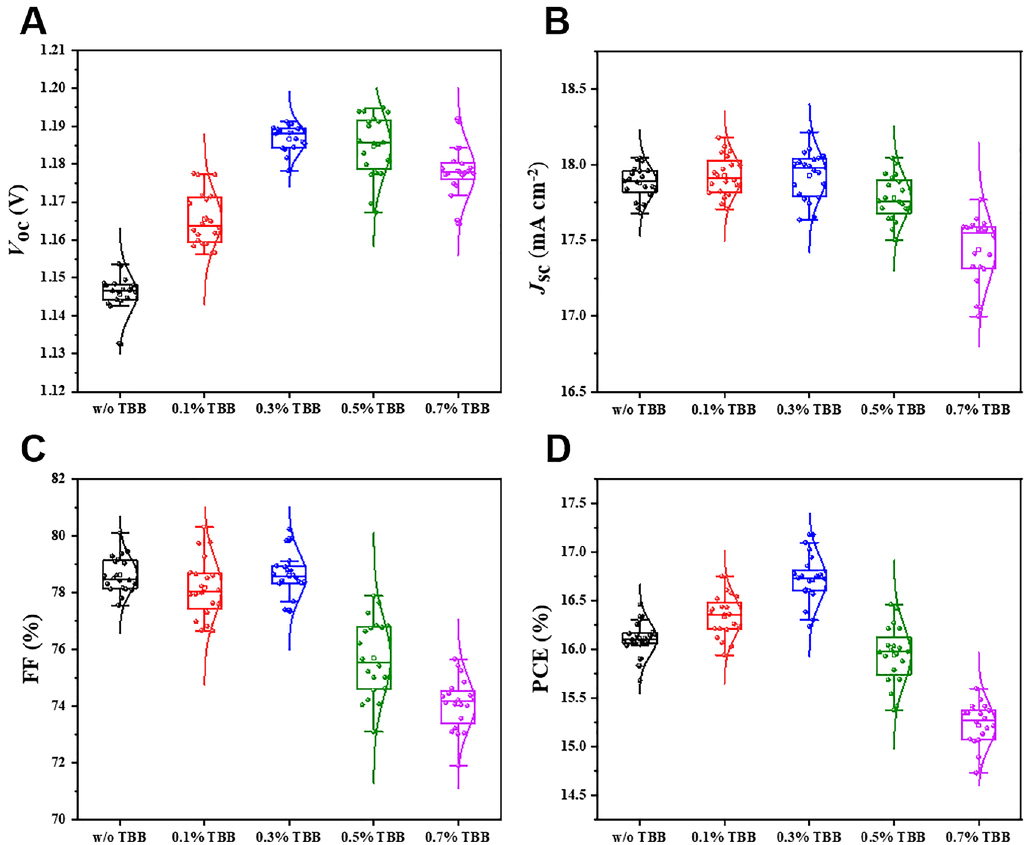
Figure 5: Statistic photovoltaic parameters of perovskite solar cells (PSCs) doped with various concentration of 1,3,5-tris (bromomethyl) benzene